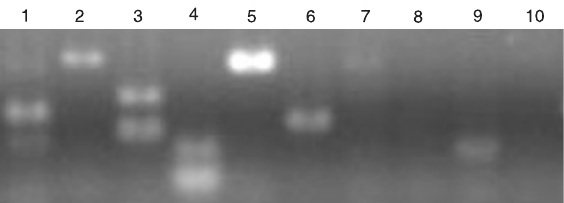
light. lane 1 : Fz receptor 1; lane 2 : Fz receptor 2; lane 3 : Fz re- ceptor 3; lane 4 : Fz receptor 4; lane 5 : Fz receptor 5; lane 6 : Fz receptor 6; lane 7 : Fz receptor 7; lane 8 : Fz receptor 8; lane 9 : Fz receptor 9; lane 10 : Fz receptor